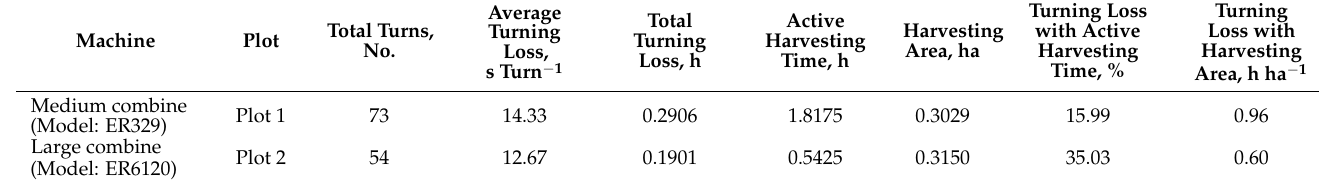
Table 2. Turning losses estimation.